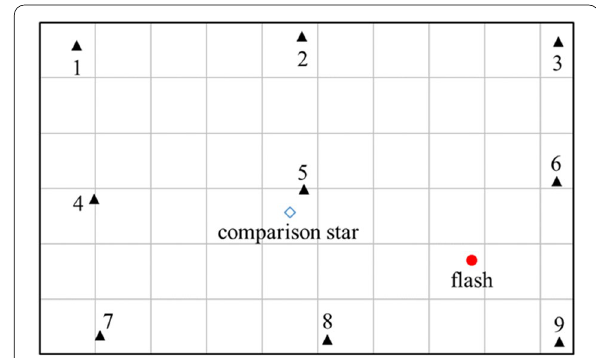
Fig. 14 The positions of images in a video frame of a star, α And (triangle plots). The count profiles derived from these spectral images were used in our spectral flat-field correction. We show the image positions of Flash 170201 by a red solid circular symbol and a comparison star, TYC 4665-715-1, by a blue open diamond